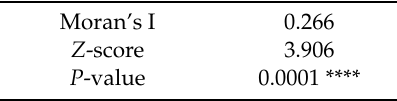
Table 5. Moran’s I of life expectancy of older people in